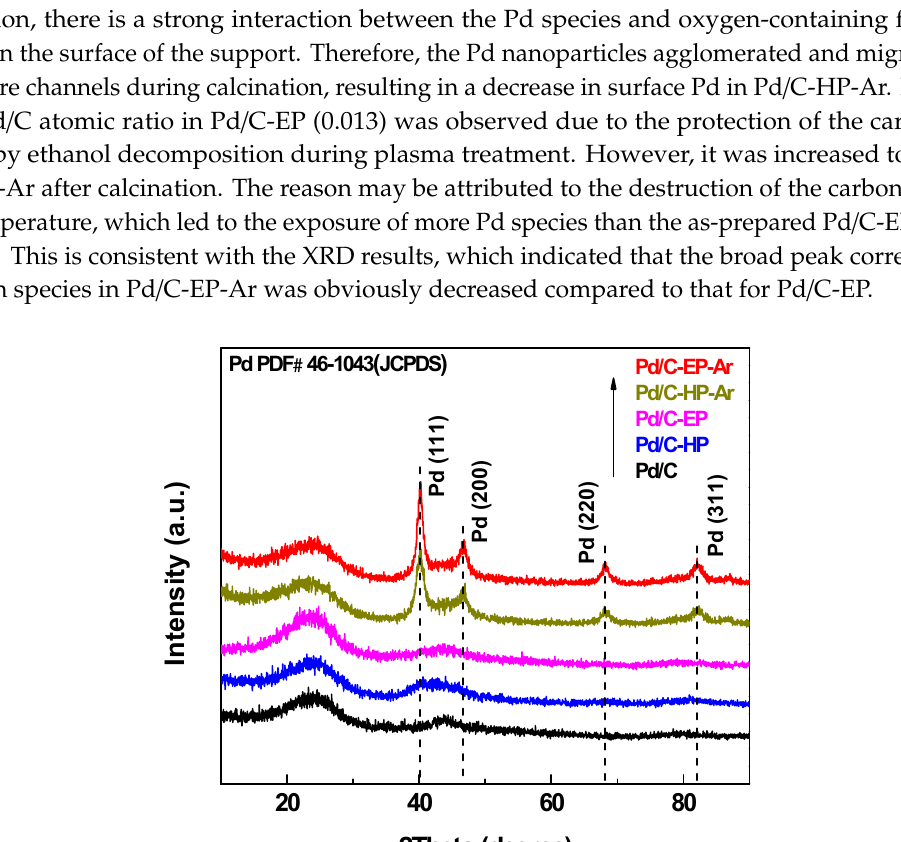
Figure 3. X-ray di ff raction (XRD) patterns of Pd / C-EP-Ar, Pd / C-HP-Ar, Pd / C-EP, Pd / C-HP, and Pd / C. Figure 3. X-ray diffraction (XRD) patterns of Pd/C-EP-Ar, Pd/C-HP-Ar, Pd/C-EP, Pd/C-HP, and Pd/C.